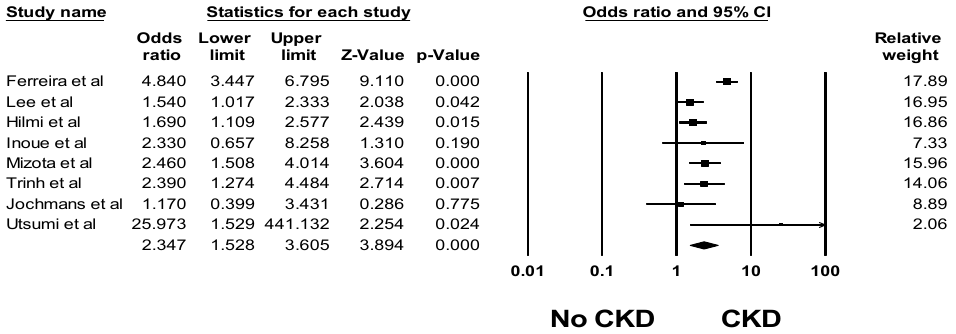
Figure 6. Forest plots of the included studies assessing CKD risk among patients with post-LTx AKI. A diamond data marker represents the overall rate from each included study (square data marker) and 95% confidence interval.